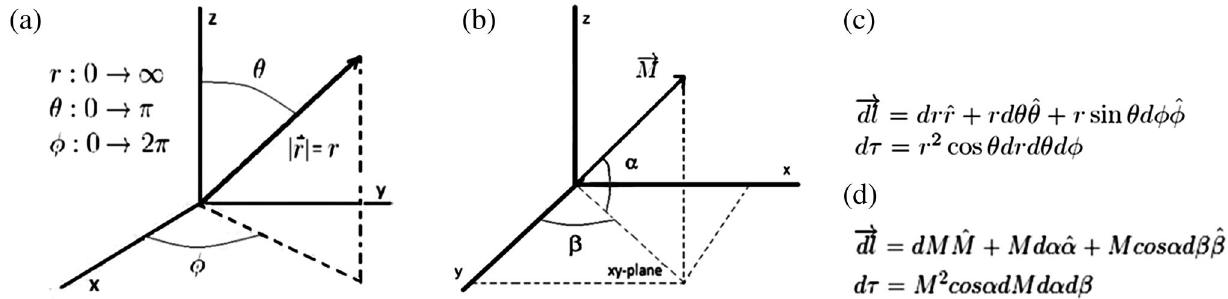
FIG. 1. (a) Conventional (physics) spherical coordinates; (b) an unconventional spherical coordinate system given to students, for which they were to construct differential length and volume elements. The correct elements for each system are in (c) and (d),